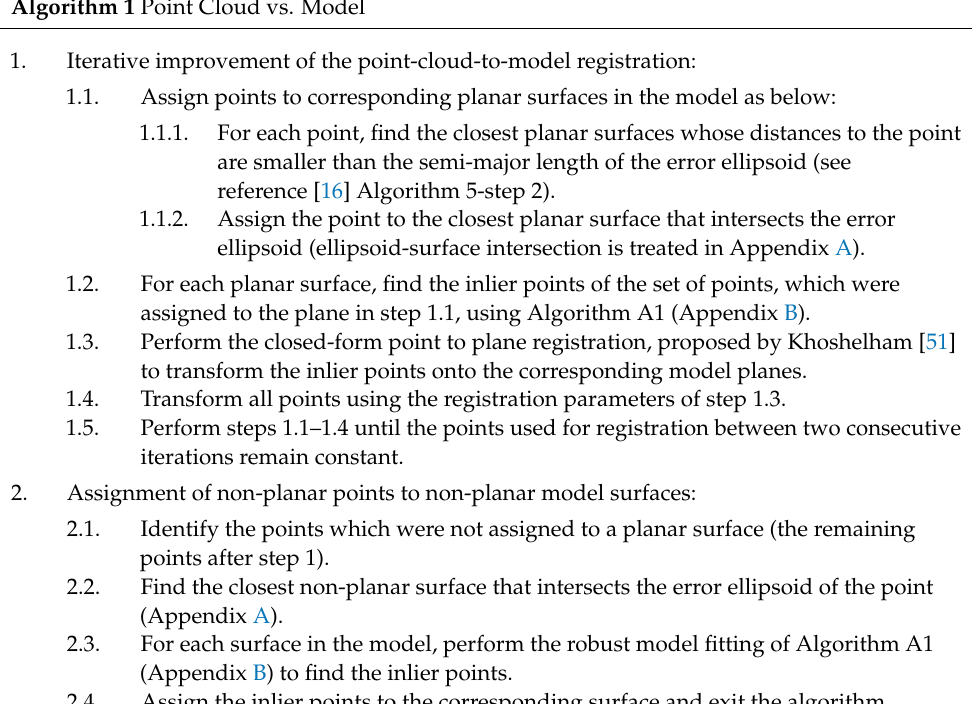
Algorithm 1 Point Cloud vs. Model